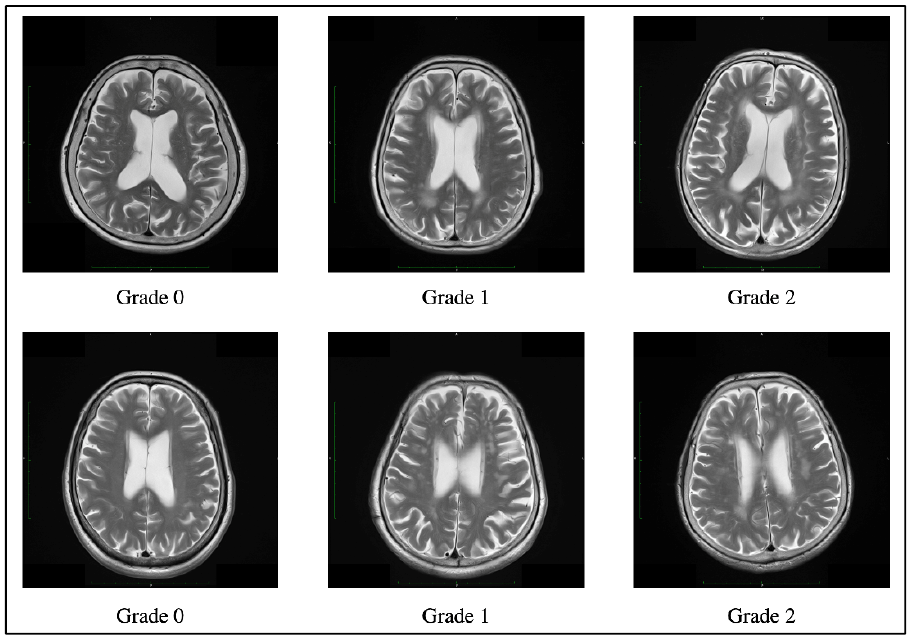
Figure 1. Example of a Fazekas scale score of 0, 1, and 2 periventricular hyperintensity ( top ) and deep white matter hyperintensity ( bottom ) on T2-weighted images. deep white matter hyperintensity ( bottom ) on T2-weighted